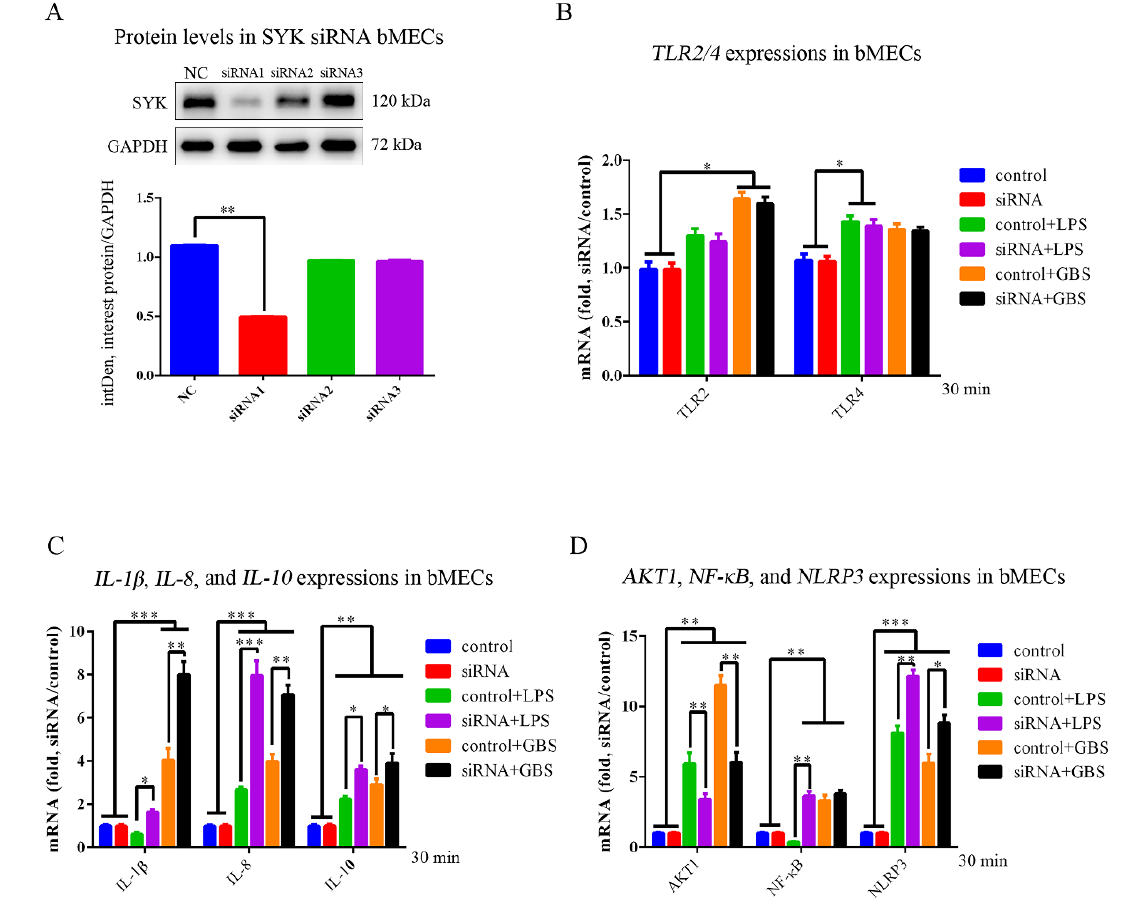
Figure 6. SYK gene siRNA interference and association genes expression in bMECs with LPS or GBS. ( A ) WB detection band showed that siRNA1 had the best interference effect in bMECs SYK- and for subsequent experiments; ( B ) TLR2 and TLR4 gene expressions in bMECs and bMECs SYK- with LPS and GBS; ( C ) IL- 1β , IL-8 and TLR4 gene expressions in bMECs and bMECs SYK- with LPS and GBS; ( D ) AKT1 , NF- κB and NLRP3 gene expressions in bMECs and bMECs SYK- with LPS and GBS. * p < 0.05, ** p < 0.01, *** p < 0.001.